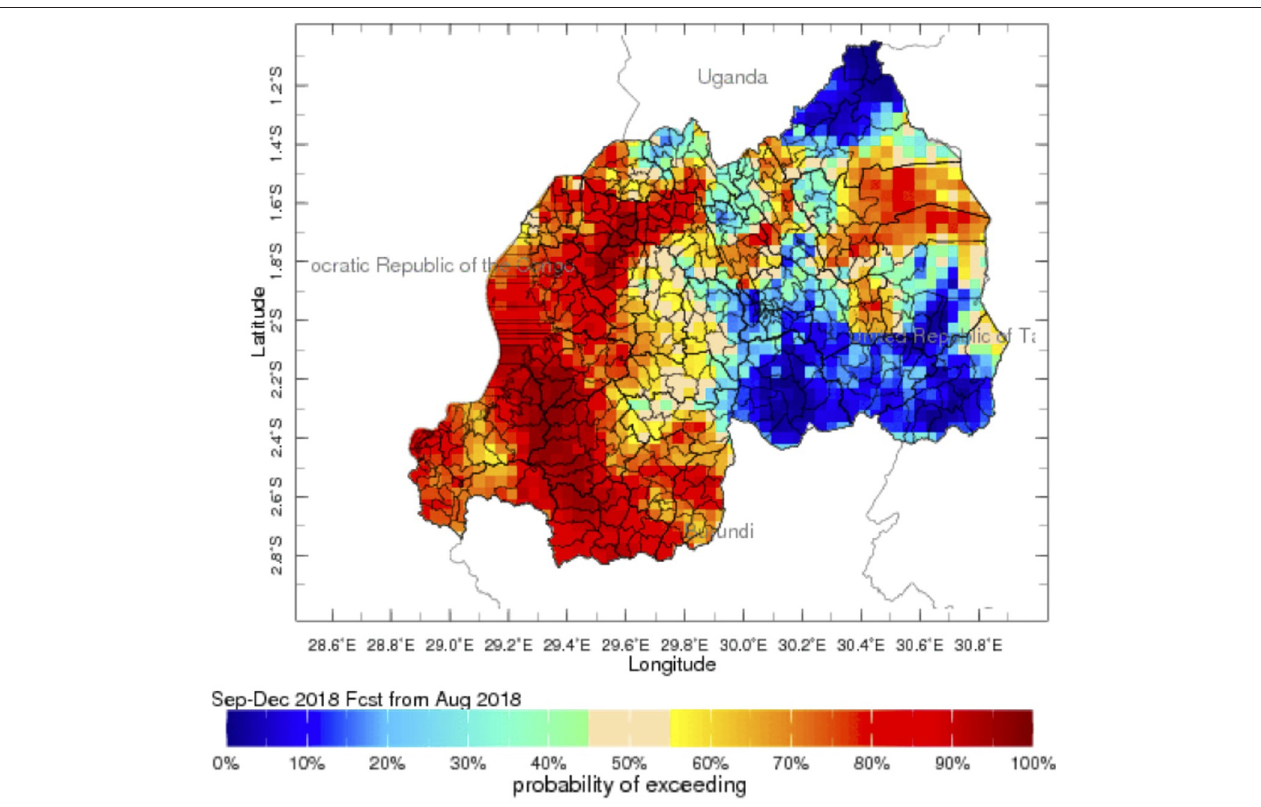
FIGURE 9 | The Flexible Forecast Maproom showing the probability of receiving over 500mm of rainfall during the forecasted season (Sep–Dec in this case).